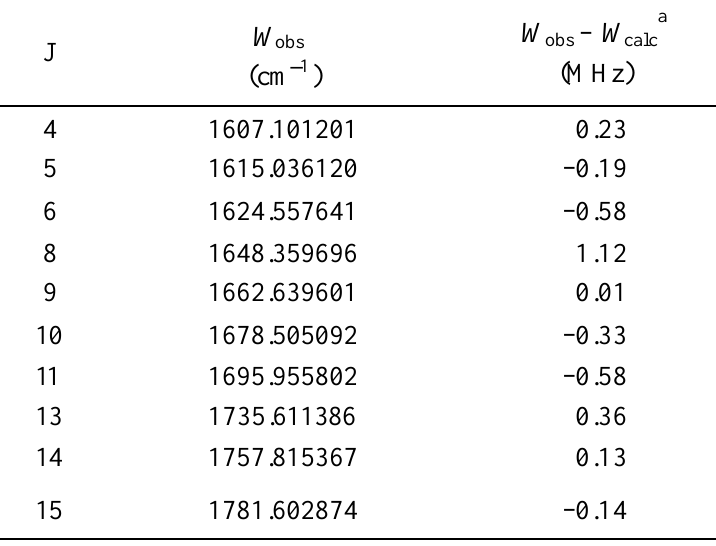
a for the (2,A, 4)